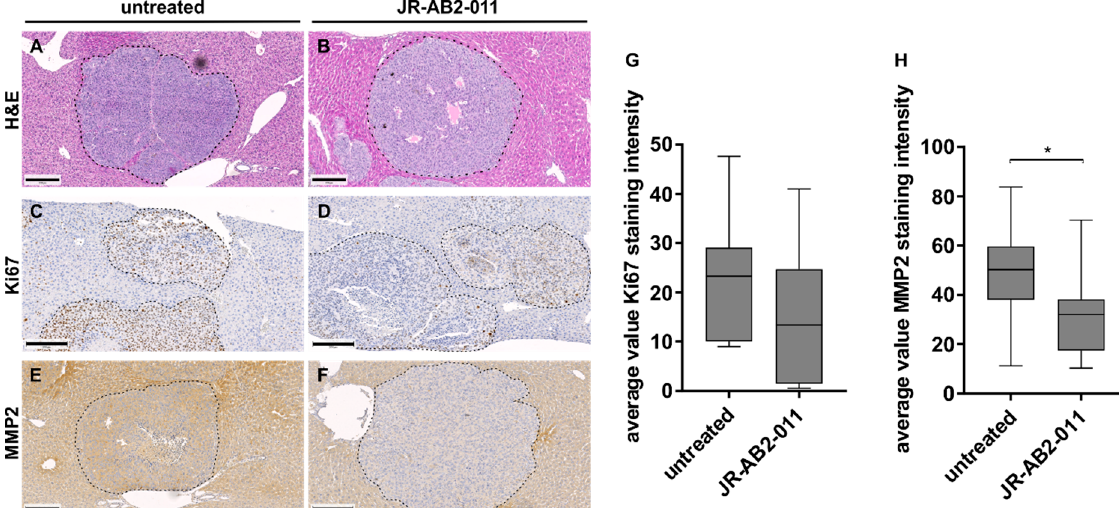
Figure 6. In vivo inhibition of mTORC2 impaired metastasis load as well as proliferation and MMP2 expression in the liver. A reduction of the metastasis load could be observed by hematoxylin and eosin (H and E) staining and is shown for untreated ( A ) and treated ( B ) mice by representative images of the dissected murine liver. The impact of the treatment on cell proliferation (Ki67) was analyzed with the ImageJ immunohistochemistry (IHC) toolbox and plotted as average value Ki67 staining intensity ( n = 16; 8/group) ( G ). Representative images of immunohistochemistry of untreated mice ( C ) and treated mice ( D ) indicate a decreased number of proliferating cells within the metastasis in the liver tissue. Staining of MMP2 revealed a significant decrease in treated mice ( F ) compared to controls ( E ), analyzed with ImageJ IHC toolbox and plotted as average value MMP2 staining intensity ( n = 16) ( H ). Metastases are marked with a dashed line. Asterisks (* p ≤ 0.05) indicate significance between treatment and the control. Scale bar indicates 200 µm (magnification × 10).